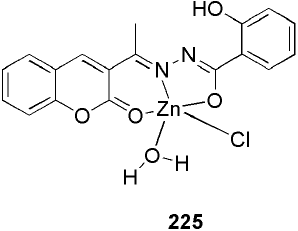
Figure 71. Chemical structure of Zn(II)-coumarin-hydrazone complex 225 . sol-gel coatings. Lately, sol-gels are gaining attention due to their chemical stability, homogeneity and technological applications (e.g., reservoir for the prolonged release of antimicrobial substances). In 2013, Jaiswal and co-workers proposed the synthesis of silver-coumarin complexes useful as antibacterial agents in sol-gel coatings [283]. These complexes were based on coumarin-3-carboxylatosilver and its hydroxylated derivatives in 6, 7 and 8. Antimicrobial activity was displayed even at concentration of 0.3% ( w / w ). The most active compound showed significative antibiofilm activity at 0.5% and 0.7% ( w / w ). These results are encouraging in the perspective of using Ag-coumarin complexes as biomedical